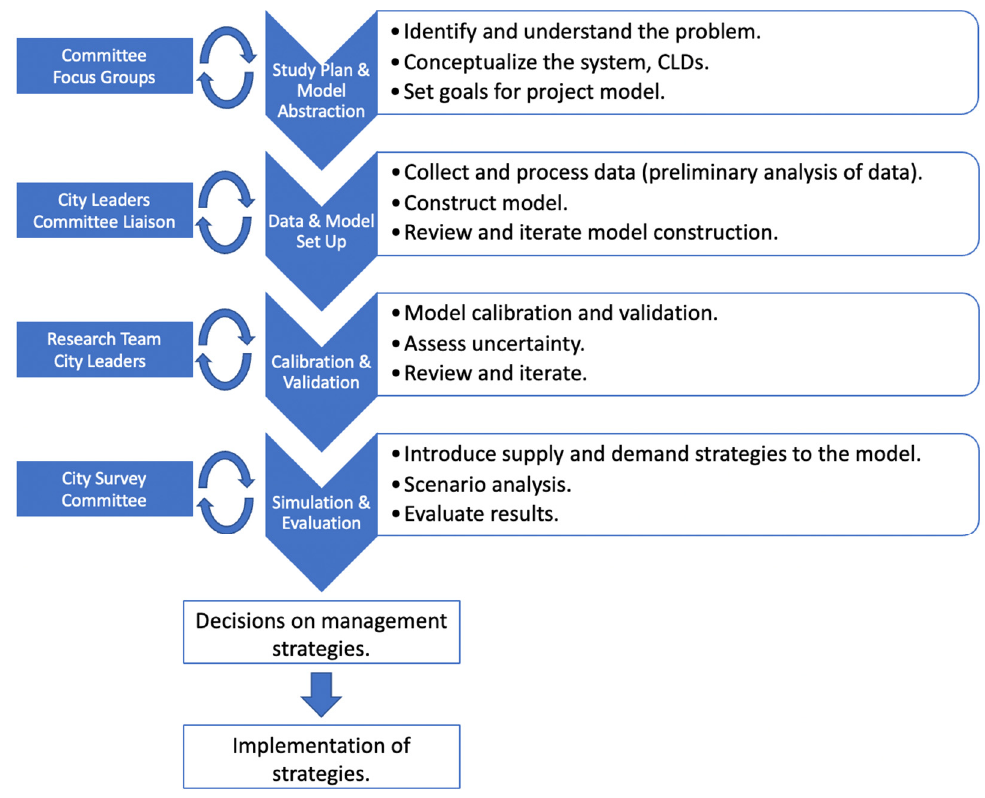
Figure 1. Interactions Between Stakeholders and the Modeling Process.